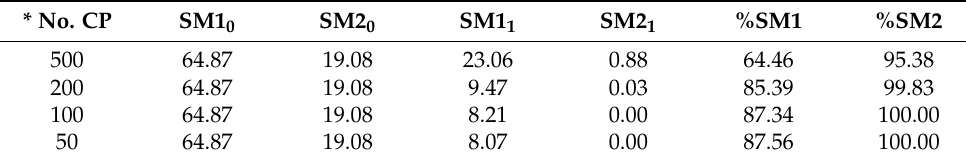
Table 2. Performance metrics of the B-spline smoothing method for different numbers of control points for approximation. The definitions of the symbols used are provided in the corresponding explanations for Equations (9)–(11). * No. CP: number of control points.